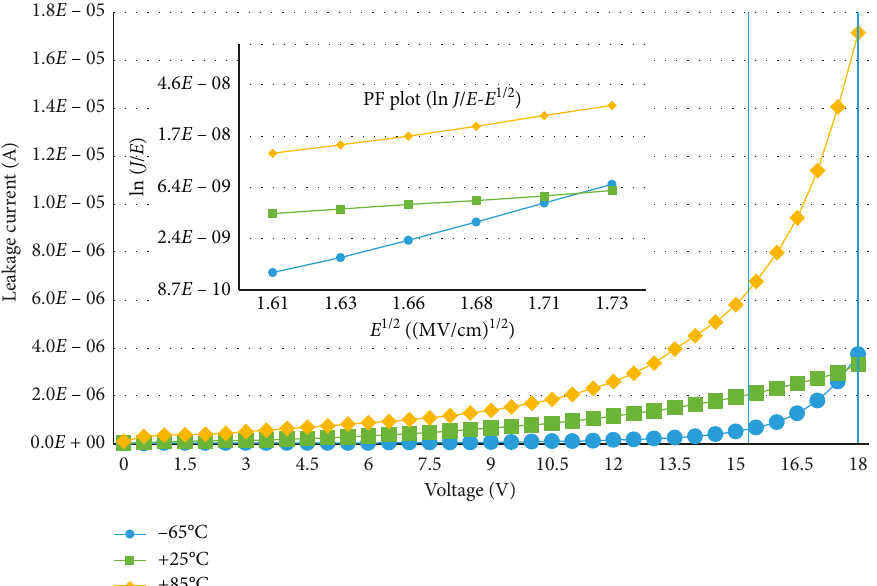
Figure 4: PF emission saturation observed in 10 V 220 μ F chip tantalum capacitors. The I - V curve at − 65 ° C converges with the curve at +25 ° C around 17V. There is no converged point with the curve of 85 ° C.